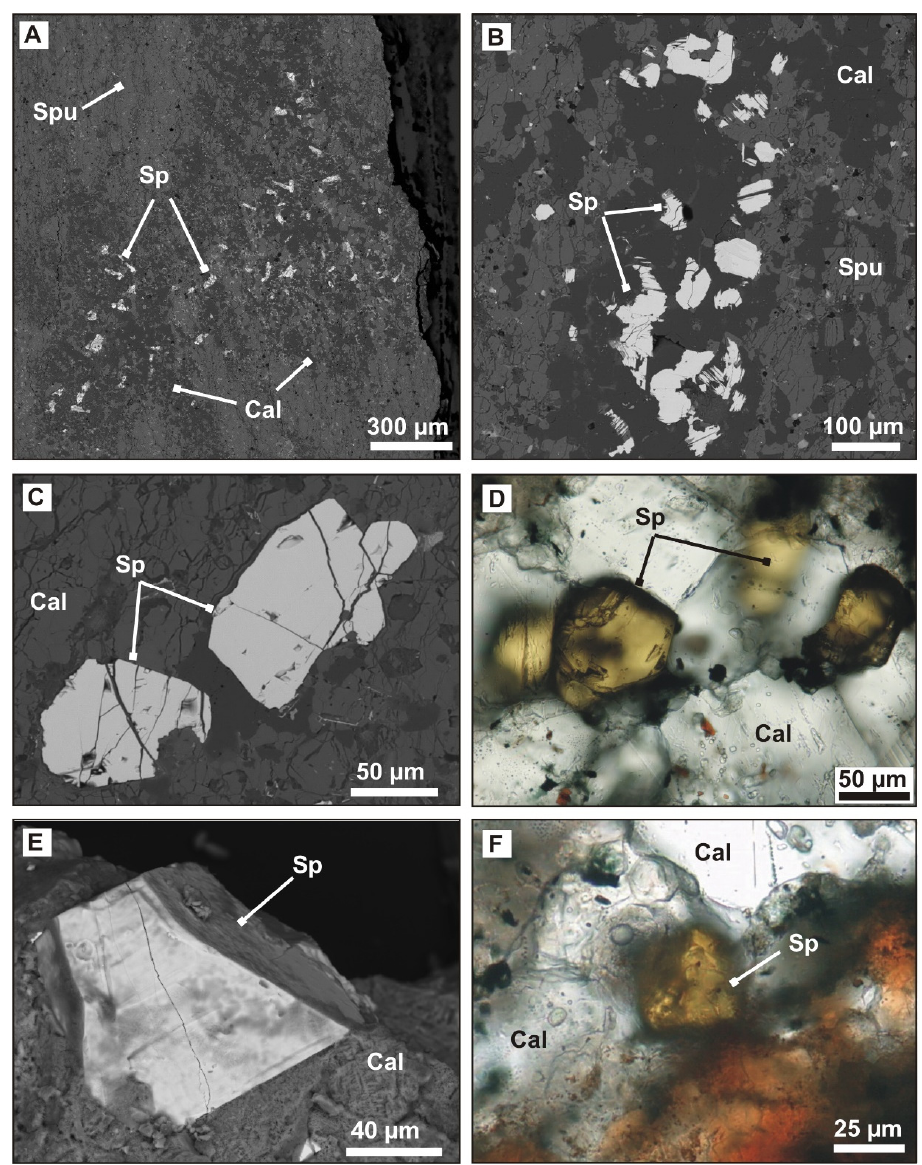
Figure 5. Sphalerite from medium-temperature combustion metamorphic spurrite-fluorapatite marbles (Tulul Al Hammam area, central Jordan). ( A,B ) Numerous large sphalerite crystals inside calcite-rich layer. ( C – F ) Tetrahedral or pseudo-octahedral sphalerite twins in a calcite matrix. Sample DT-25 ( A ), sample DT-26 ( B ), sample DT-20 ( C – F ). Optical images in plane-polarized light ( D , F ) and BSE images ( A – C , E ). Cal = calcite, Sp = sphalerite, Spu = spurrite.